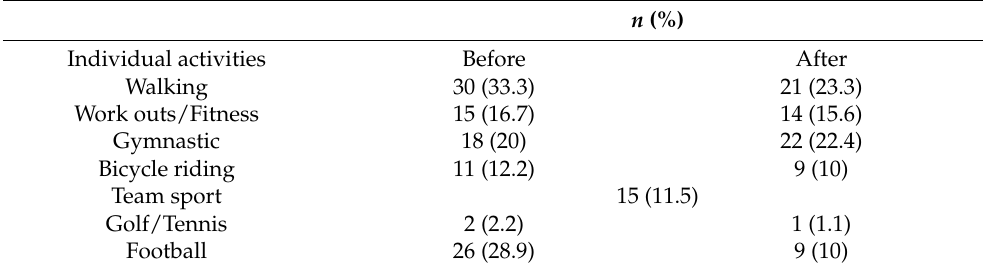
Table 9. Type of physical activities before and after surgery.